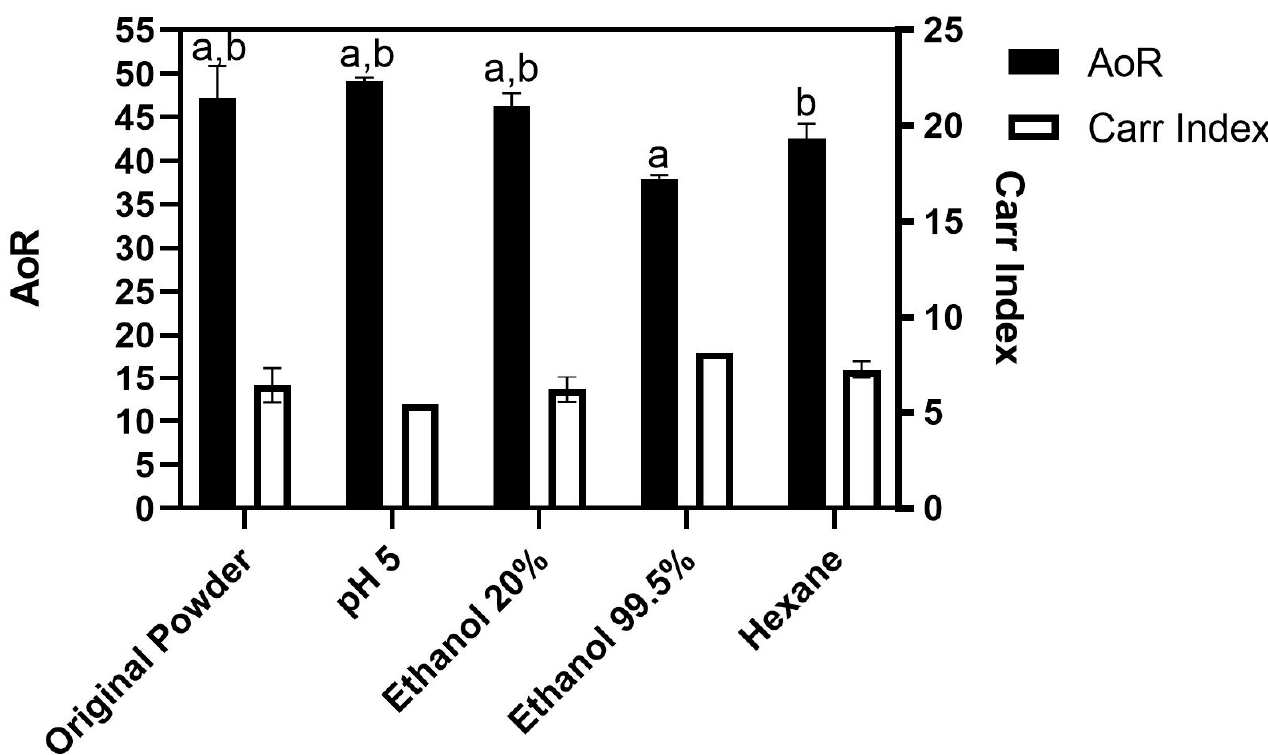
Figure 8. Evaluation of flowability using angle of repose (AoR). Letters represent significant difference ( p < 0.05). a = Ethanol 99.5% vs. original powder, pH 5, and ethanol 20%. b = hexane vs. original powder, pH 5, and ethanol 20%. Carr index classification ranges from 0 to 25, in which 0–4.5 is very bad, 5–9.5 is bad, 10–14.5 is not good, 15–17 is normal, 17.5–19.5 is good, 20–22 is fairly good and 22.5–25 is very good flow. Classification of flowability according to Carr Index. (Hosokawa Powder Tester Model PT-X Operating Manual, Page D-53.) .